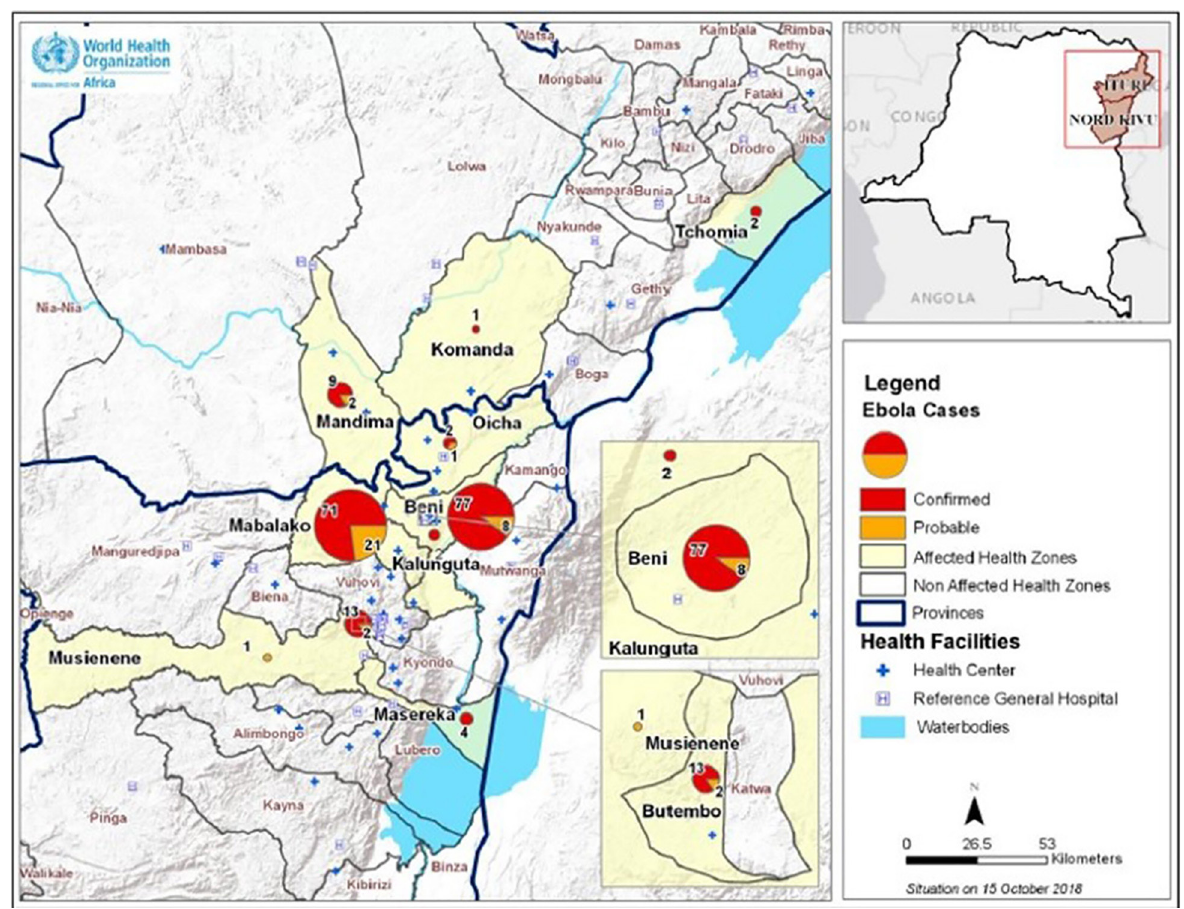
Fig. 4. Map from the WHO